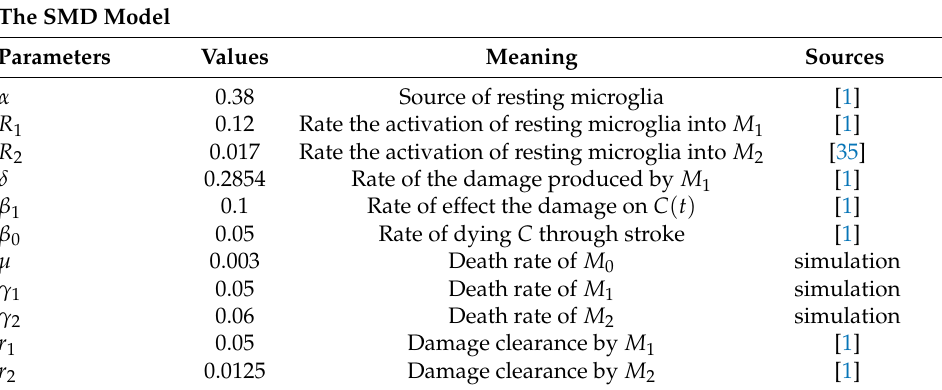
Table 1. Parameters values for the stroke-microglia-damage (SMD)